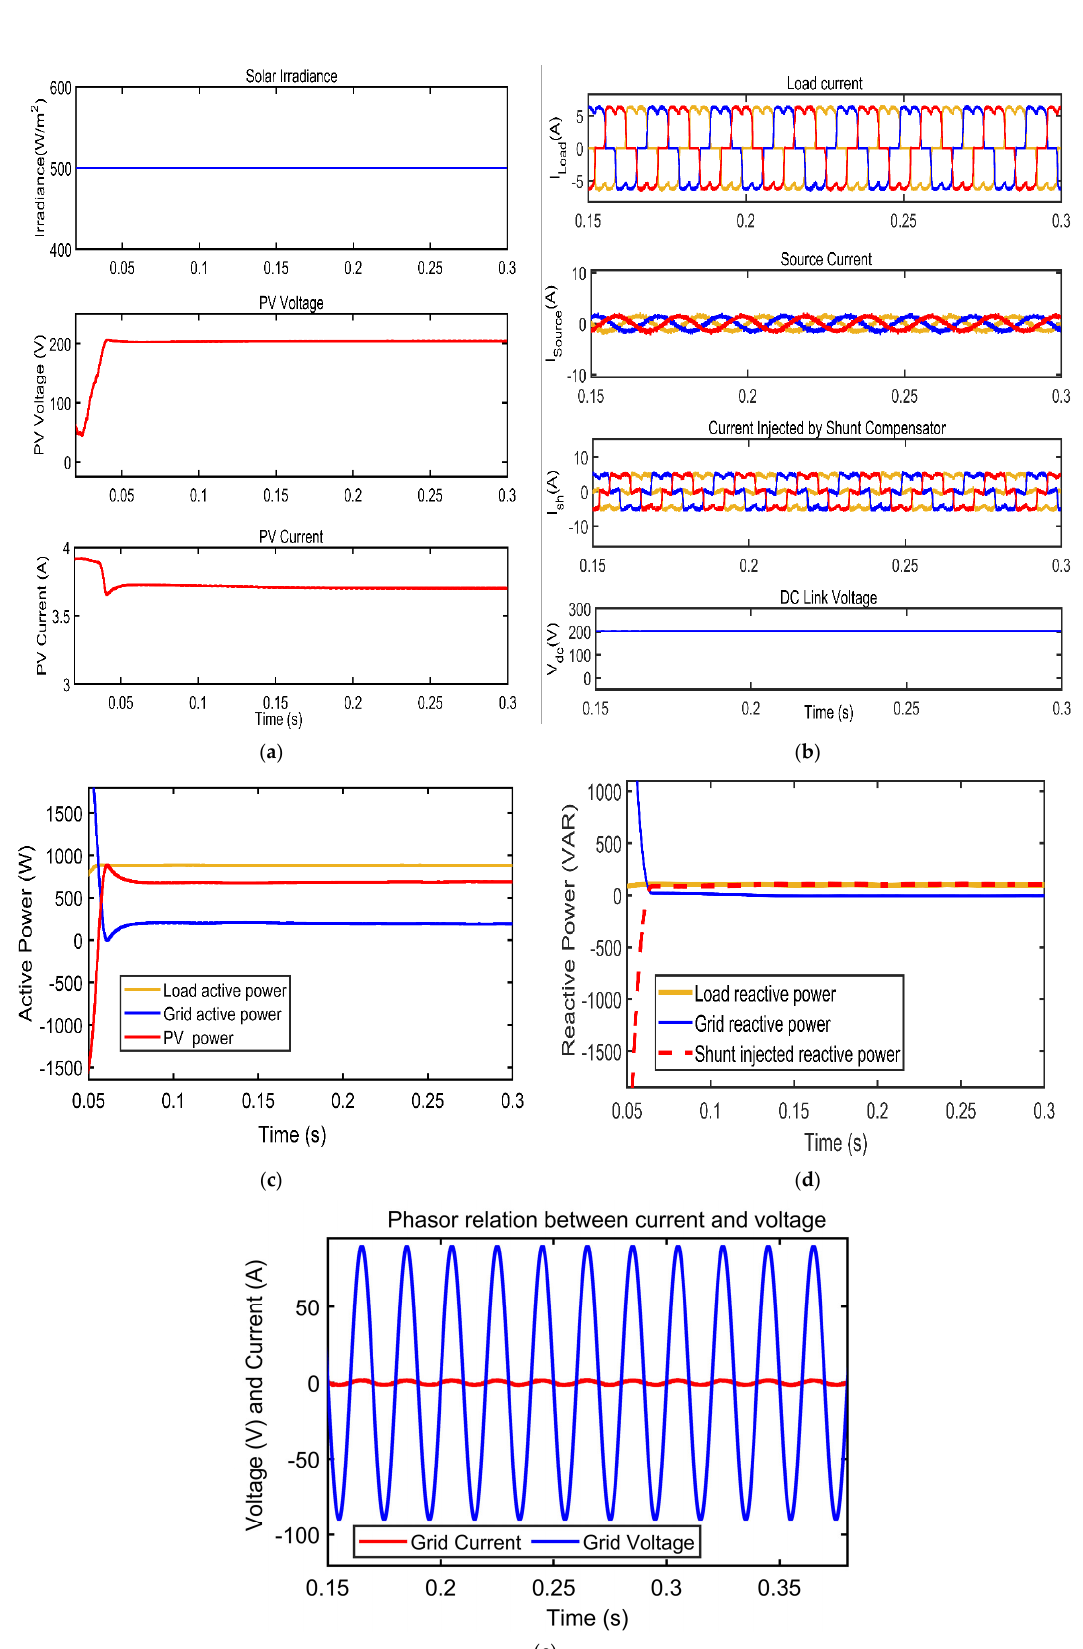
Figure 4. Under steady–state condition ( a ) PV voltage and current at 500 W/m 2 ; ( b ) performance of PV–DSTATCOM; ( c ) real power balance between PV, grid and load; ( d ) reactive power balance between PV, grid and load; ( e ) phase relation between voltage and current.